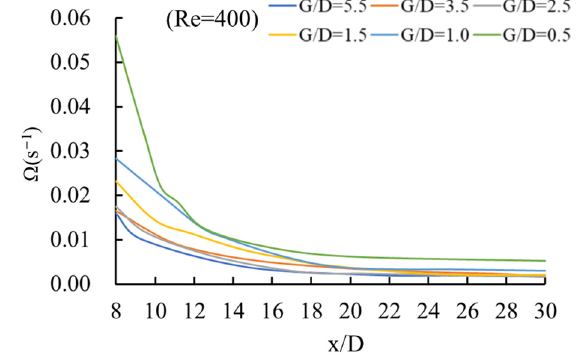
Figure 8. Variation of the vorticity of the flow around a square cylinder along the flow direction under different boundary constraint degrees.